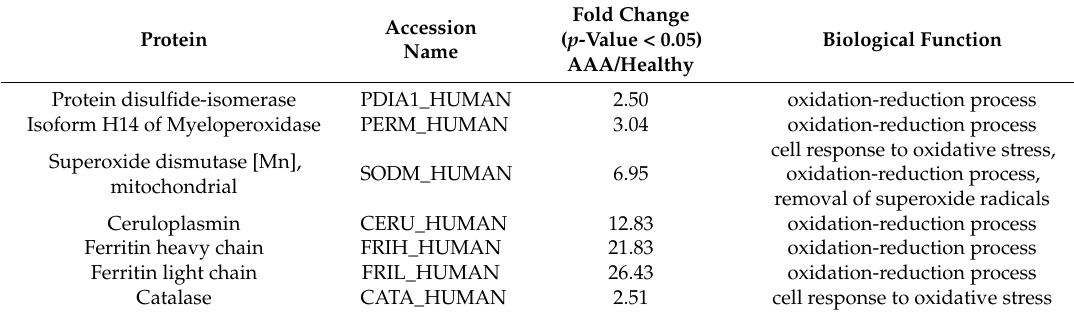
Table 1. Proteomic analyses results. Upregulated proteins in AAA vessel tissue after comparison to healthy tissues by proteomic analysis. The upregulated proteins were selected using p value < 0.05. Protein